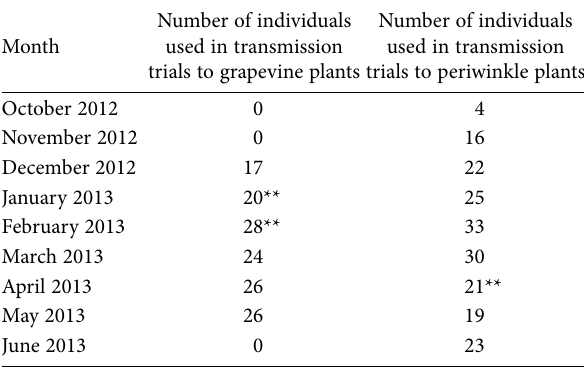
Table 2. Numbers of Bergallia valdiviana individuals captured in the Casablanca vineyard. Insects were released each month in cages to feed on periwinkle and grapevine plants for phytoplasma trans- mission